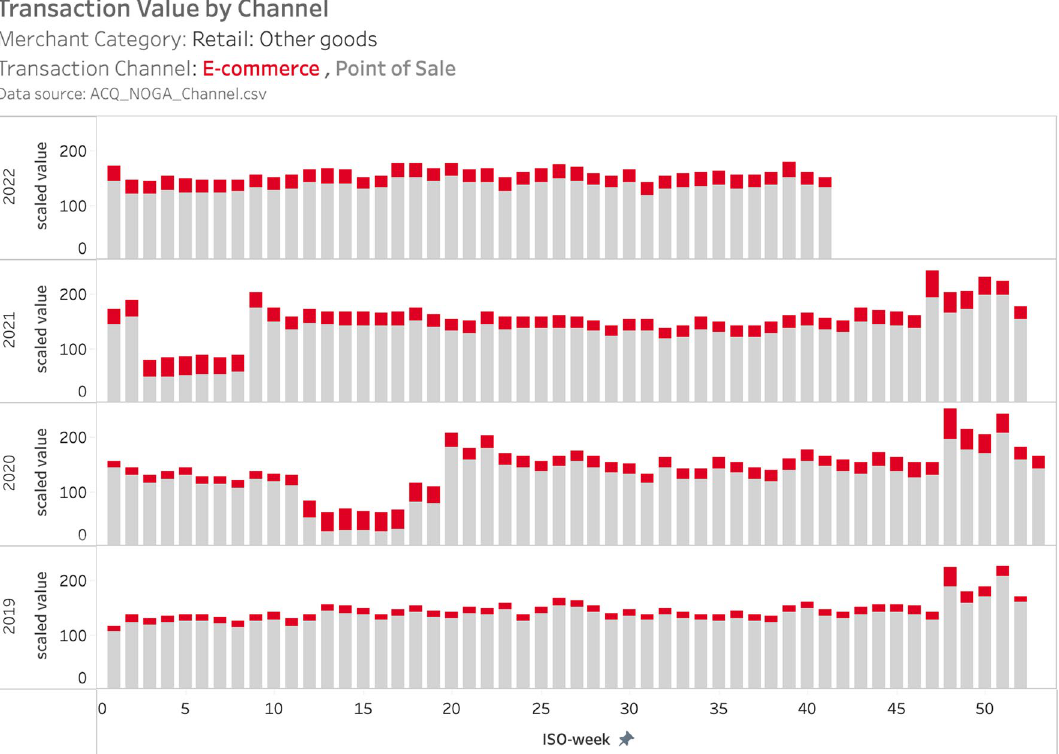
Fig. 10 Ecommerce vs. PoS spending in non-food retail. Note : The figure displays scaled total weekly spending with debit cards, credit cards and mobile payments at merchants in the Retail: other goods ( non-food) category for 2019–2022. Spending at PoS terminals is displayed in gray, = spending at ecommerce terminals is displayed in red. We display the project data as provided, i.e., as a scaled value, which preserves the relative interpretability both over time and in the cross-section. See Sect. 2 for more details. Data source: